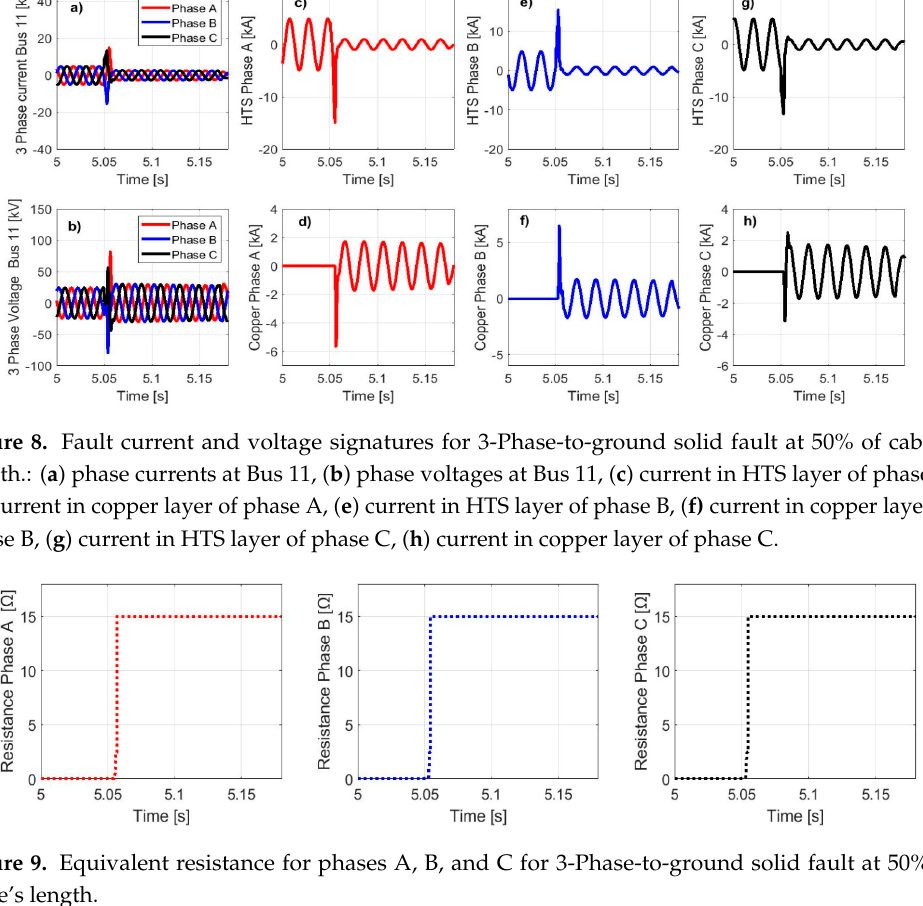
Figure 10. Temperature for phases A, B, and C for 3-Phase-to-ground fault at 50% of cable’s length. Figure 11. Fault current signatures for Phase-A-to-ground solid fault at 50% of cable’s length.: ( a ) phase currents at Bus 11, ( b ) phase voltages at Bus 11, ( c ) current in HTS layer of phase A, ( d ) current